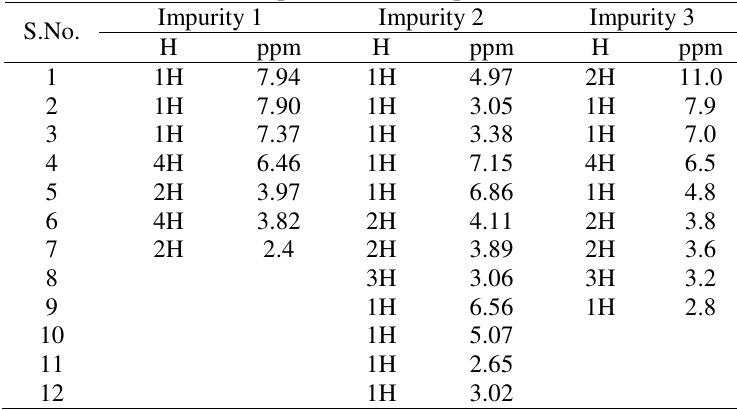
Table 2. 1 H NMR spectral date of impurities